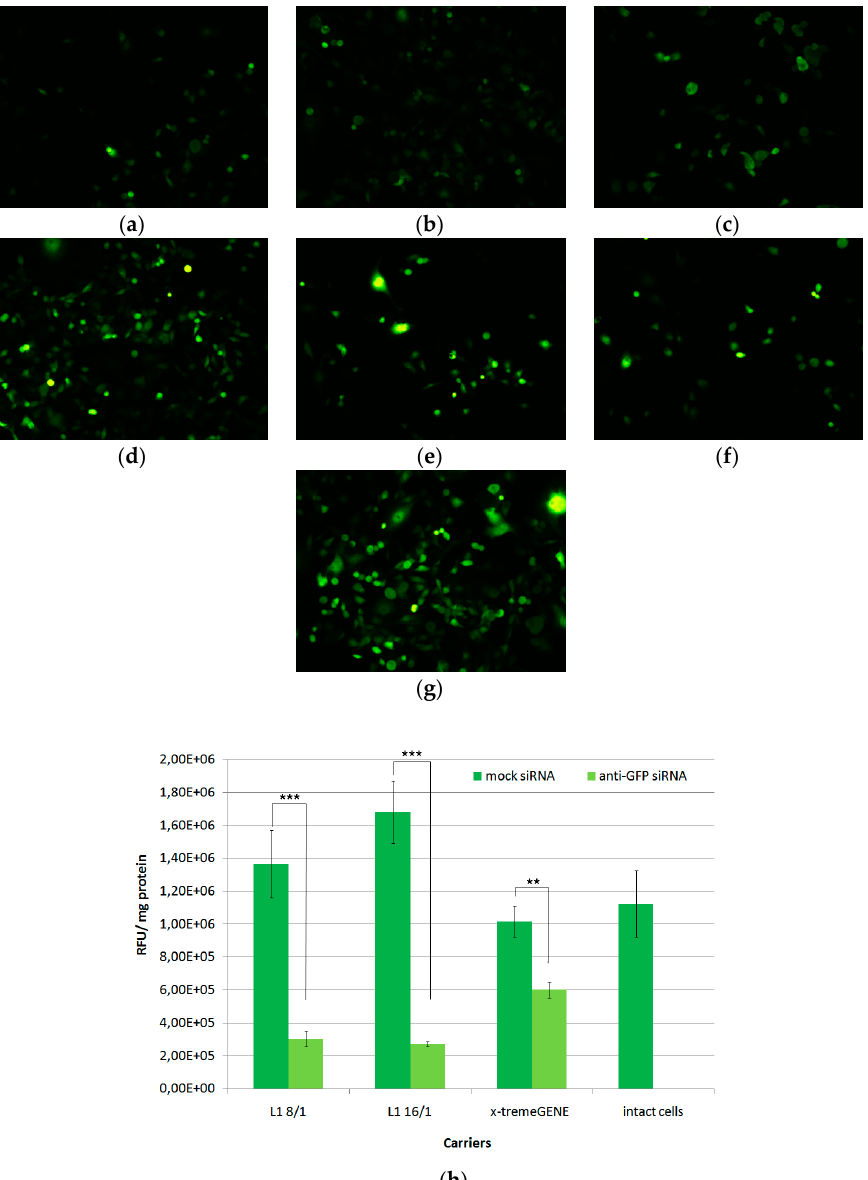
Figure 2. Silencing of the GFP gene expression after the treatment of MDA-MB-231 cells with L1/siRNA and X-tremeGENE/siRNA complexes. The visual appearance of MDA-MB-231 cells (magnification ×100) after treatment with ( a ) L1/anti-GFP siRNA (N/P 8/1),( b ) L1/anti-GFP siRNA (N/P 16/1), ( c ) x-tremeGENE/anti-GFP siRNA, ( d ) L1/mock siRNA (N/P 8/1), ( e ) L1/mock siRNA (N/P 16/1), ( f ) x-tremeGENE/mock siRNA complexes (200 nM siRNA), and ( g ) intact cells. ( h ) Quantitative analysis of GFP gene expression, ** p < 0.01, *** p < 0.001 when compared with cells treated by mock siRNA-complexes.